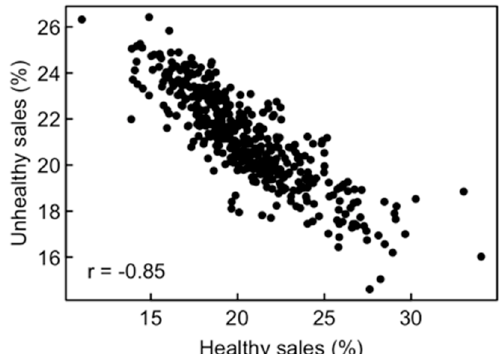
Figure 2. Negative correlations between sales of healthy and unhealthy food types across the 445 stores. Each point represents one store. Values are the sum of sales of the six food types included in each group, expressed as the percentage of a store’s total annual food sales. Table 3. Loadings of each food type on the first three axes of a principal components analysis (PCA) based on a correlation matrix of sales percentages. The fraction of variation represented by each PCA axis is given in the first row. For the first PCA axis, light-grey shading indicates food types associated with the healthy side of the sales gradient, and dark-grey shading indicates the food types associated with the unhealthy side of the sales gradient. Horizontal lines subdivide the three a priori categories (healthy, unhealthy, both/basic, cf. Table 2).